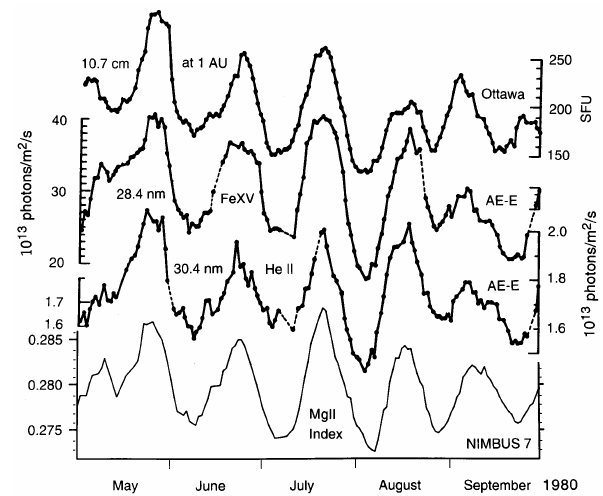
Fig. 1. The Mg II index (bottom curve), the 30.4 nm (He II) and 28.4 nm (Fe XV) from AE-E, and the 10.7 cm solar emissions from May to September 1980 (top plot extracted from Avrett,